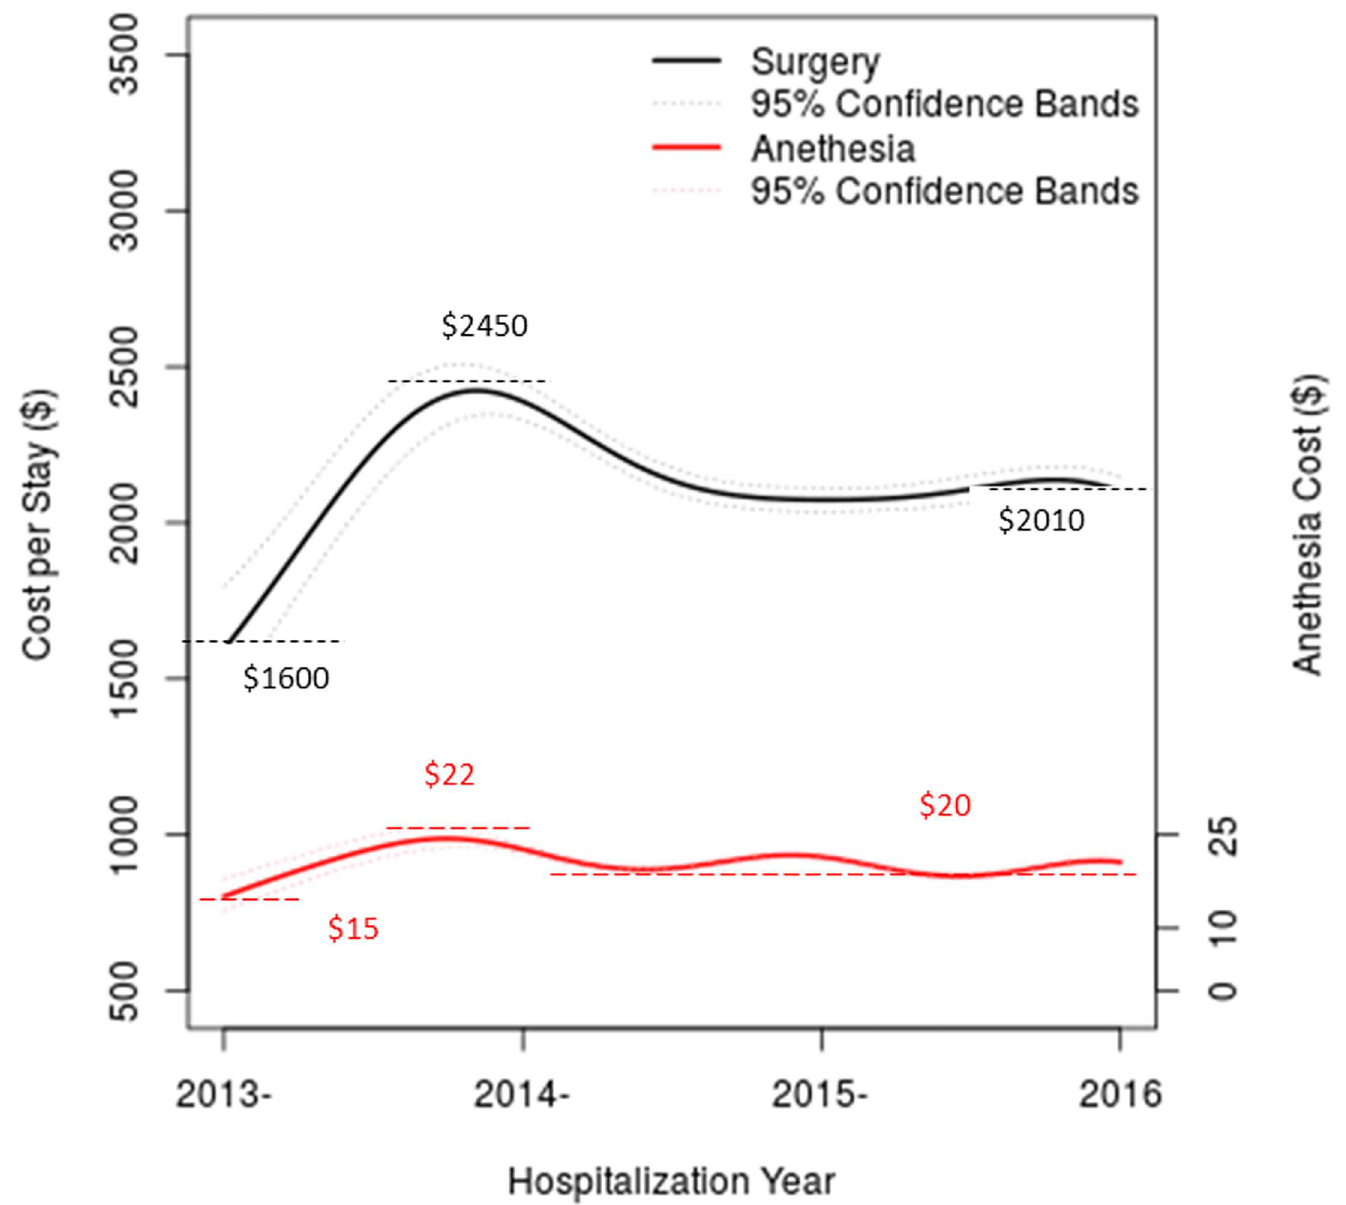
Fig 3. Temporal trends of surgery-specific cost per stay indicated by the left y-axis (from $0 to $2,500),and temporal trends of anesthesia cost indicated by the right y-axis (from $0 to $40).